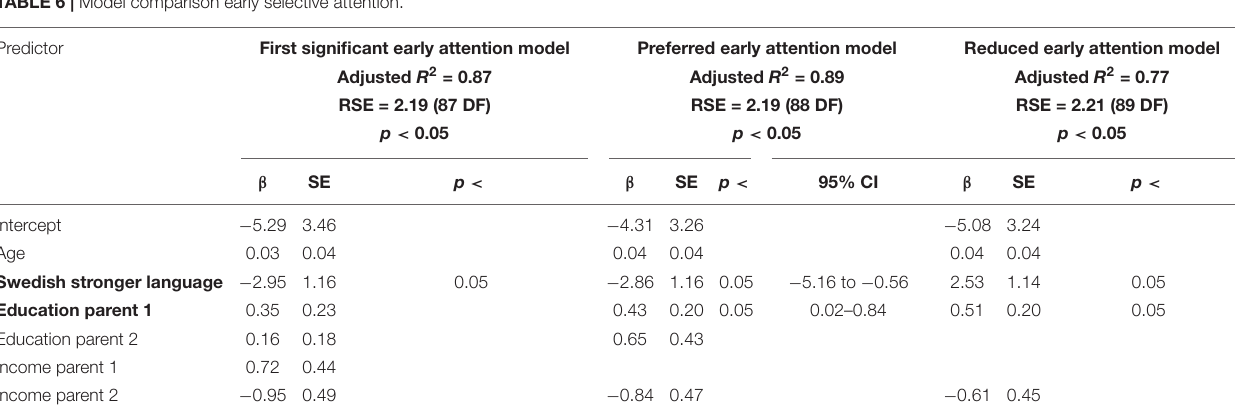
TABLE 6 | Model comparison early selective